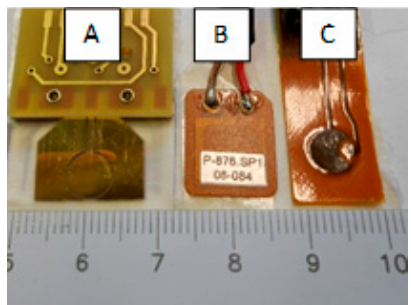
Figure 3. Picture of the three types of piezoelectric sensors used in this work. From left to right: custom circular PVDF (type A); Physik Instrumente P-876.SP1 (type B); and, Acellent SML-SP-1/4-0 (type C).